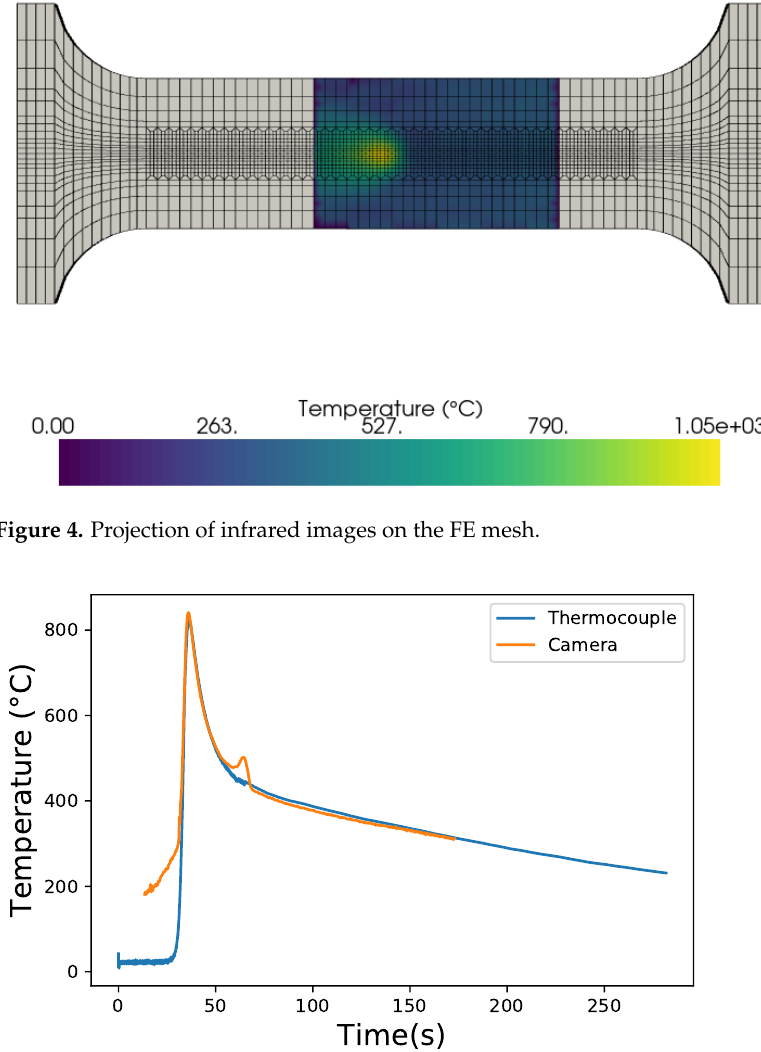
Figure 5. Temperature measures taken with a thermocouple and an infrared camera.